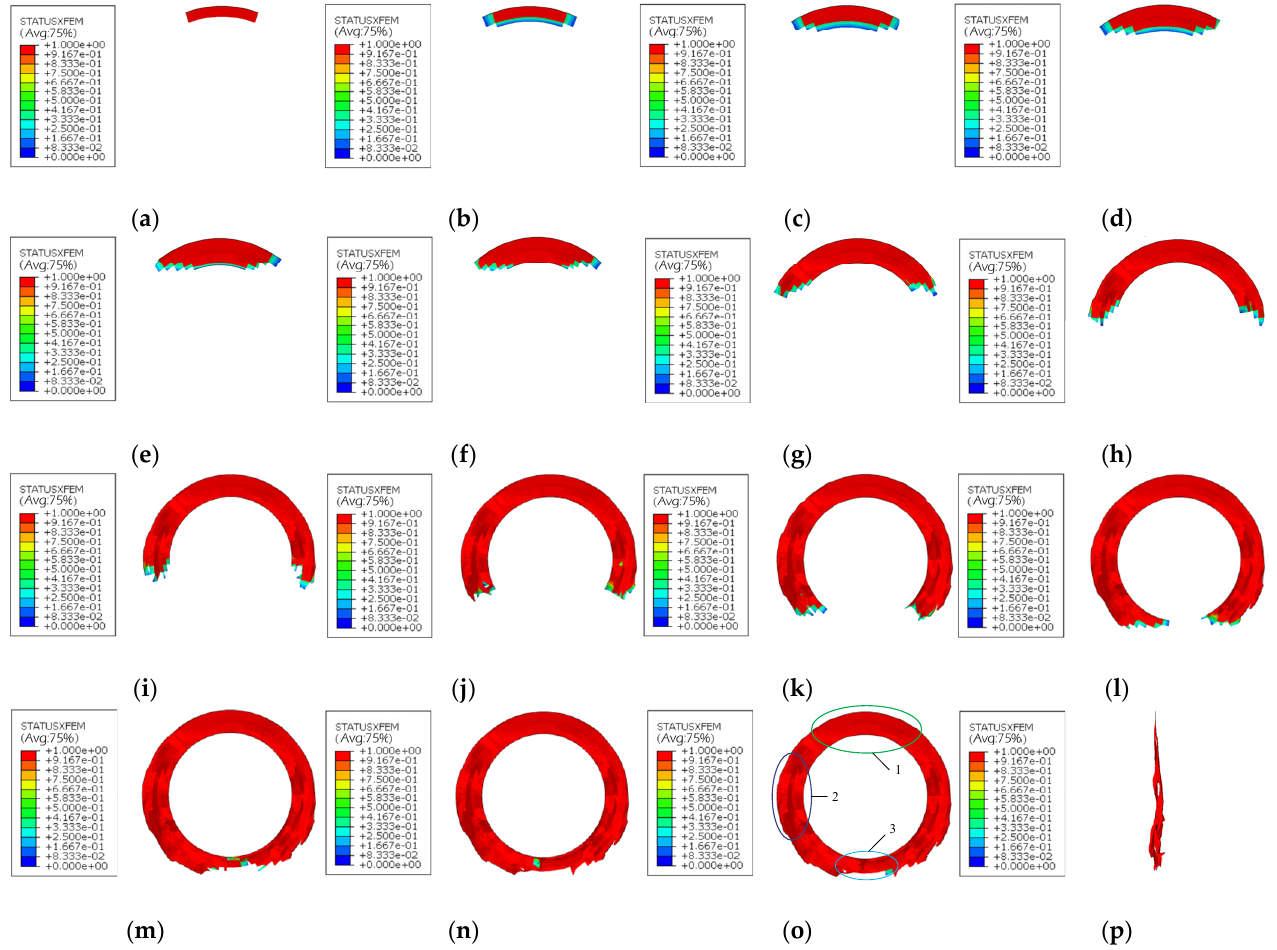
Figure 15. Tubing fatigue fracture precision separation process: ( a ) N = 0; ( b ) N = 10; ( c ) N = 20; ( d ) N = 30; ( e ) N = 40; ( f ) N = 50; ( g ) N = 100; ( h ) N = 150; ( i ) N = 200; ( j ) N = 250; ( k ) N = 300; ( l ) N = 350; ( m ) N = 400; ( n ) N = 450; ( o ) N = 500; ( p ) Crack face.